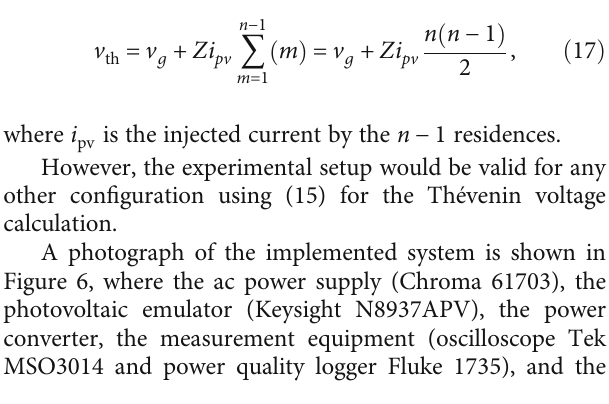
, 10A/div). Time 11